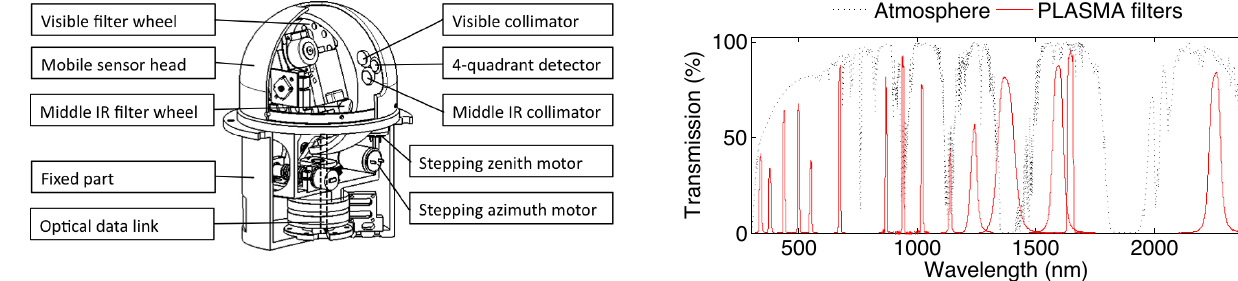
Fig. 2. PLASMA filter’s transmission.